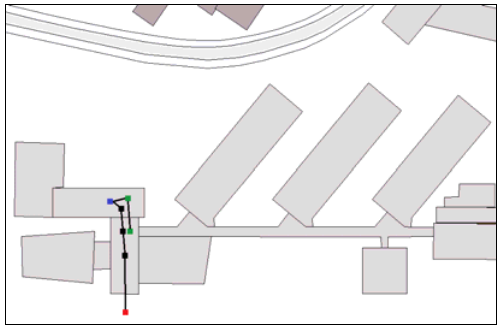
Figure 2. The Faculty of Engineering and the buildings coding